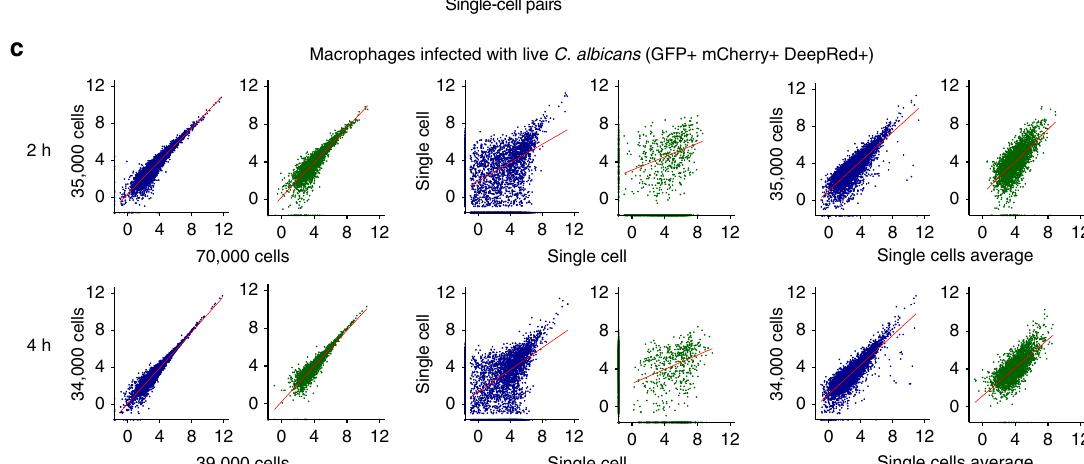
Fig. 3 Processing and evaluation of parallel host-pathogen single-cell RNA-Seq. a Schematic representation of the experimental model for sorting and scRNA-Seq analysis of single macrophages infected with C. albicans . In the heatmap, the color scheme of gene expression level (log 2 (TPM + 1)) varies from − 1.5 (purple) to 1.5 (yellow)) This approach simultaneously produces the transcriptome of both macrophages and C. albicans and allows resolve population heterogeneity and trace distinct trajectories during host – pathogen interaction. b Plot of the percent of mapped reads to the composite reference transcriptome (mouse messenger and ribosomal RNA + Candida albicans messenger and ribosomal RNA collections) of 314 single macrophages with live (mCherry + GFP + ) or with dead, phagocytosed (mCherry + GFP − ) phagocytosed C. albicans cells. c Plots of the gene expression correlation between (left) two replicates of the sorted subpopulation of macrophages (blue) with phagocytosed live C. albicans (green) at 2 and 4 h postinfection; (middle) between two single macrophages and two phagocytosed C. albicans , and (right) between the single cells expression average and one replicate of the